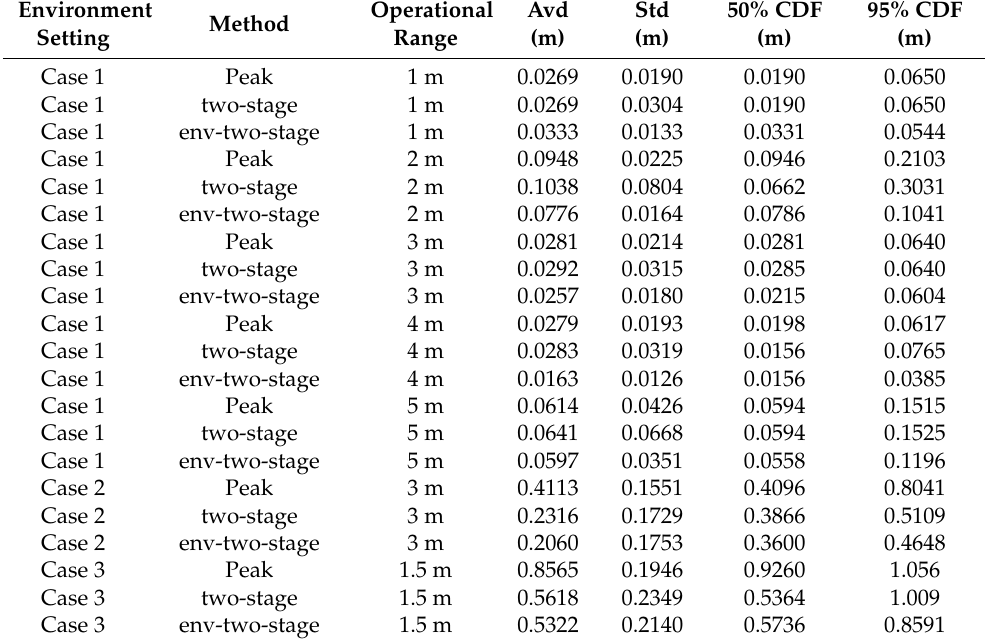
Table 3. Summary of all experimental results. Avd and Std are the average and stand error of the results.